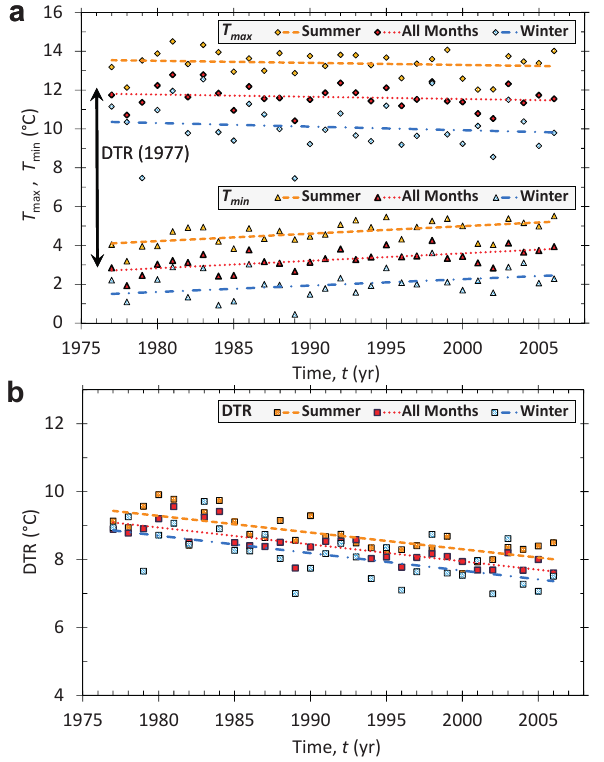
Fig. 6. Annual mean maximum temperatures ( T max ), minimum temperatures ( T min ), and diurnal temperature ranges (DTR), for 1977–2006, based on hourly Mauna Loa Observatory, Hawaii data (NOAA, 2009), given for “all months” during the year, summer (June, July, August) and winter (December, January, February). (a) The sequence of annual mean maximum temperatures T max (di- amonds) and minimum temperatures T min (triangles) are given as a function of time t for 1977–2006, for all months considered to- gether (dark red diamonds/triangles, same as Fig. 5a), summer (yel- low diamonds/triangles) and winter (blue diamonds/triangles). An illustration of DTR= T max − T min for 1977 is also shown (vertical arrow). (b) The annual mean values of DTR are given as a function of time t , for all months considered together (red squares, same as Fig. 5b), summer (triangles) and winter (circles). Also shown in (a) and (b) are best-fit linear trends of the annual values (dashed lines: summer; dotted lines: all months; dash-dotted lines: winter). The slopes for each line in (a) and (b) ( ± 1s.e. of the slope) are summa- rized in Table 2, along with those from equivalent analyses for fall and spring.